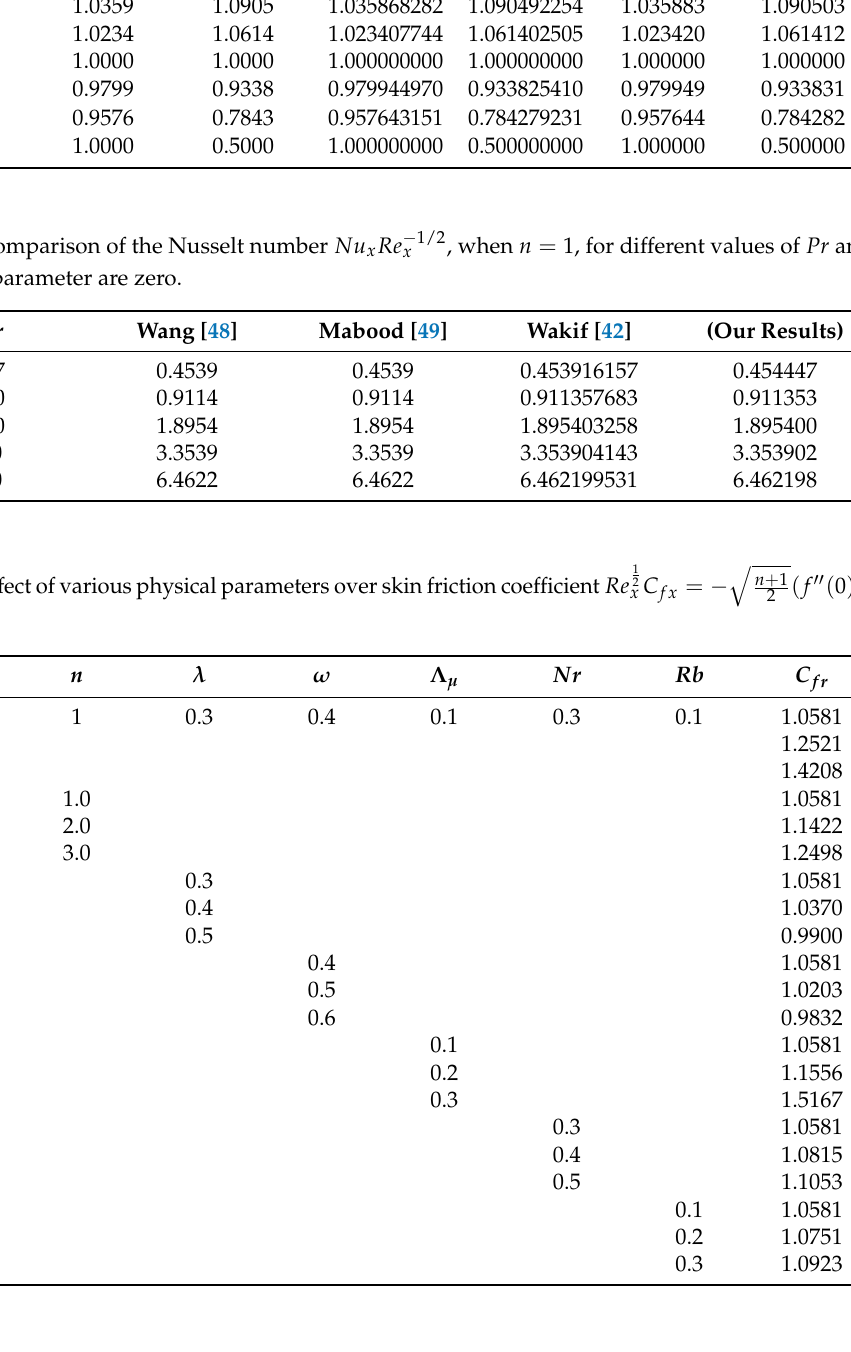
1 2 x (skin friction coefficient) for different values of n and variable Table 1. Comparison of C fx Re thickness ς , when ignored other parameters.